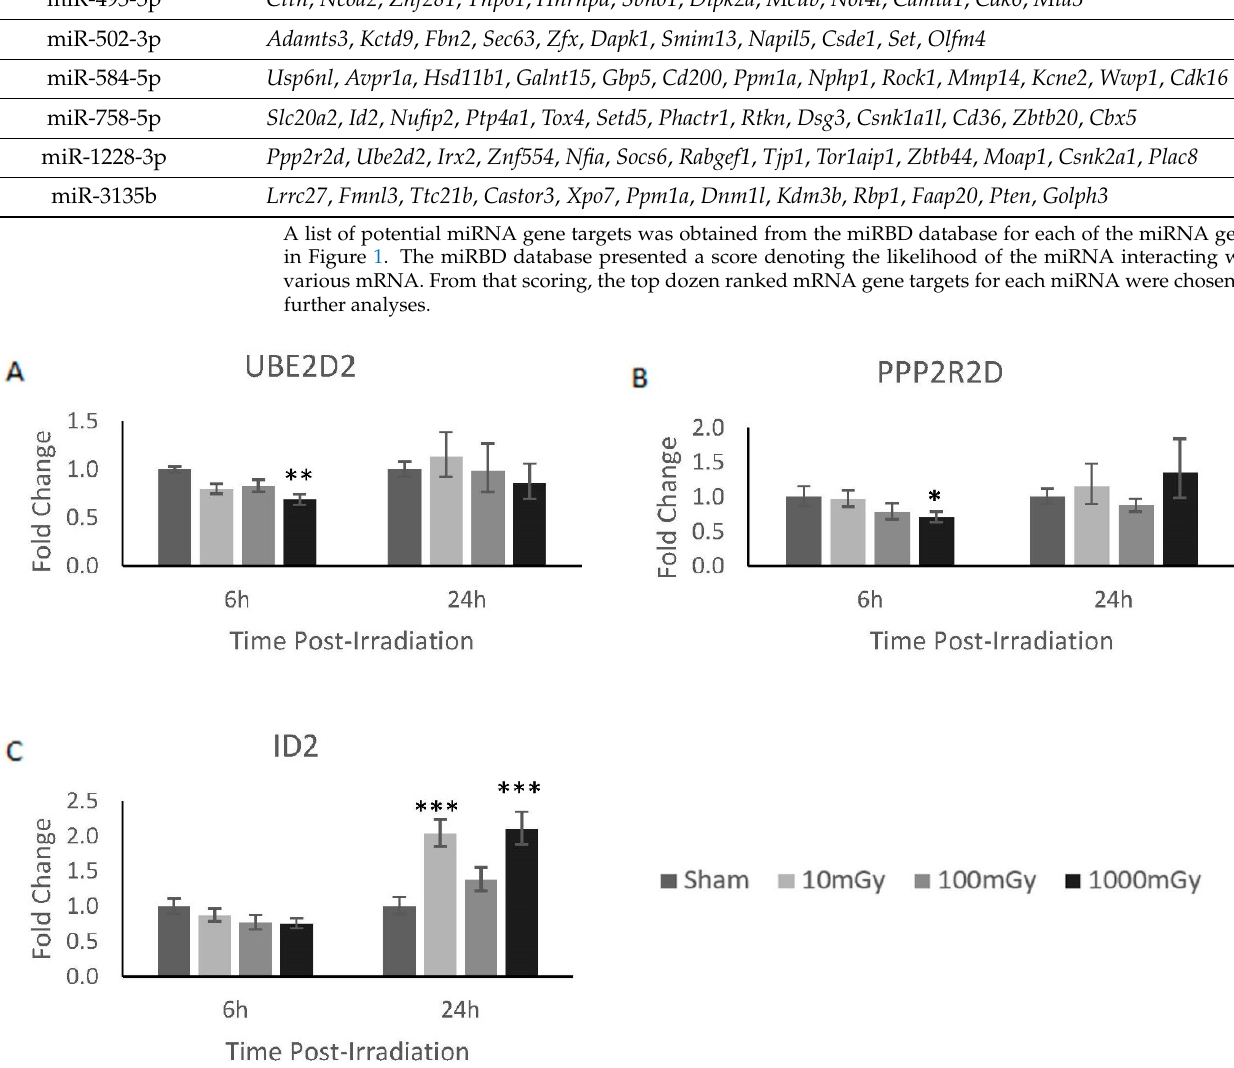
Figure 2. mRNA gene targets of miR-1228-3p and miR-758-5p showed reciprocal expression. Of the validated possible mRNA interaction shown in Table 2, three mRNA gene targets demonstrated a reciprocal gene expression pattern to their corresponding miRNA. In brief, ( A ) Ube2d2 and ( B ) Ppp2r2d demonstrated a reciprocal expression pattern to miR-1228-3p at 6 h, whereas ( C ) Id2 showed a reciprocal expression pattern to miR-758-5p at 24 h. Significance is denoted with asterisks, where * = p < 0.05, ** = p < 0.01, and *** = p < 0.001.